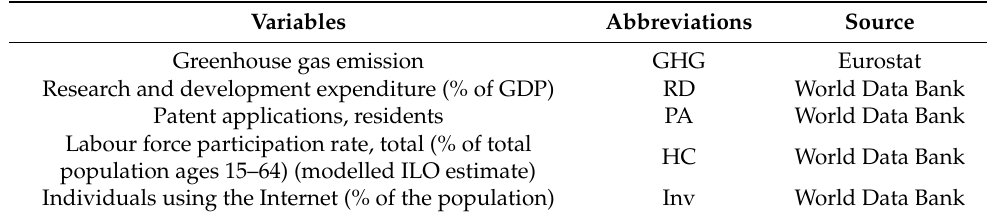
Table 2. Explanation of the variables (Source: developed by the author). Variables Abbreviations Source Greenhouse gas emission Research and development expenditure (% of GDP) Patent applications, residents PA Labour force participation rate, total (% of total HC World Data Bank population ages 15–64) (modelled ILO estimate) Individuals using the Internet (% of the population) Inv World Data